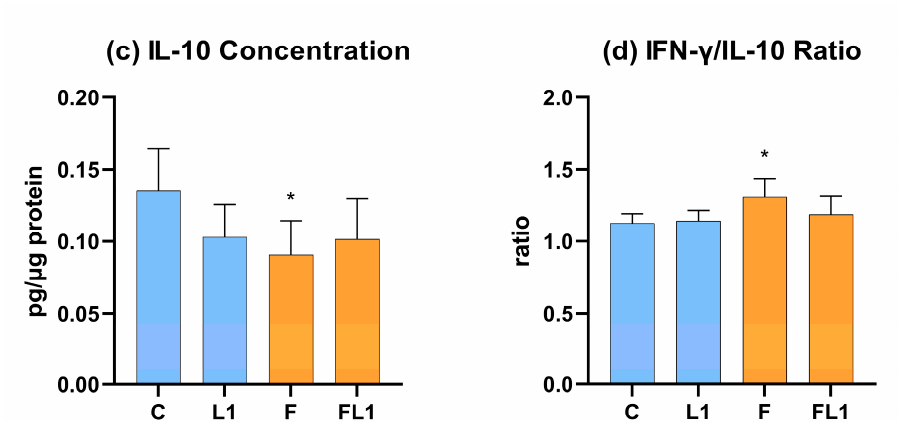
Figure 3. IFN- α ( a ), IFN- γ ( b ), IL-10 ( c ) concentration of the cell culture medium measured by chicken-specific Luminex MAGPIX Panel and the IFN- γ / IL-10 ratio ( d ). C = control, L1 = luteolin (4 µg/mL), F = flagellin (250 ng/mL), FL1 = flagellin (250 ng/mL) and luteolin (4 µg/mL). Mean ( n = 6/group) ± SD, * p < 0.05, ** p < 0.01. Group L1 and F were compared to C, while group FL1 was compared to group F.